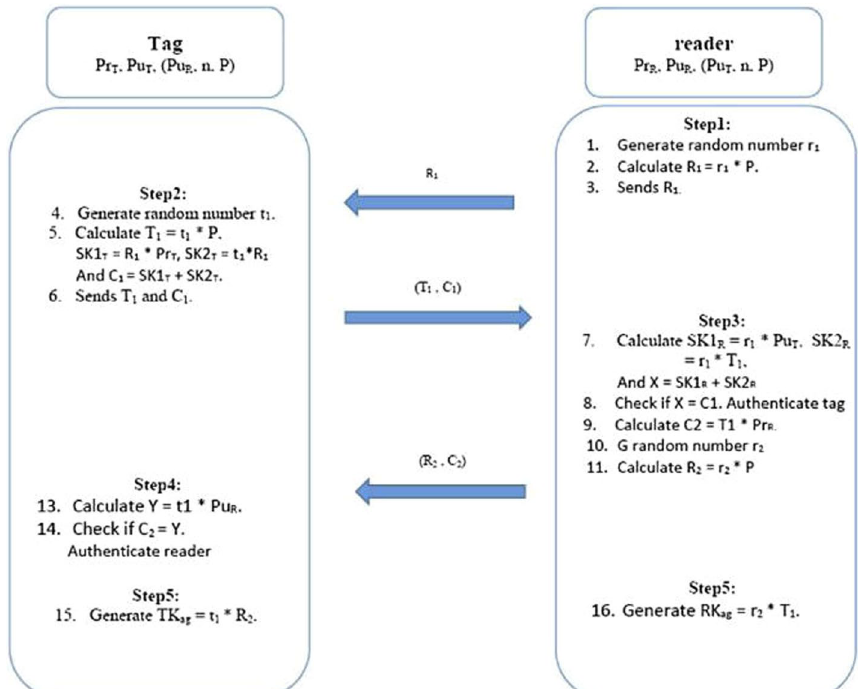
Fig. 1 The authentication protocol of Alamr scheme